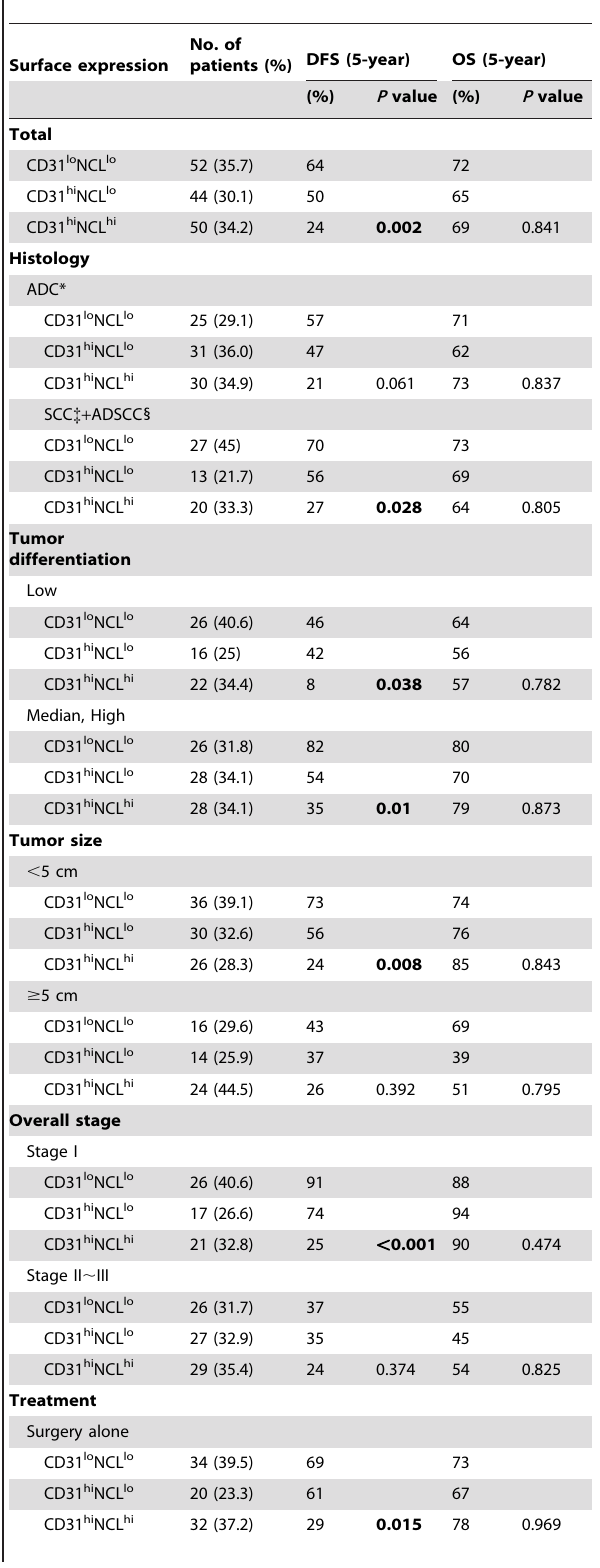
No. of Surface expression patients (%) DFS